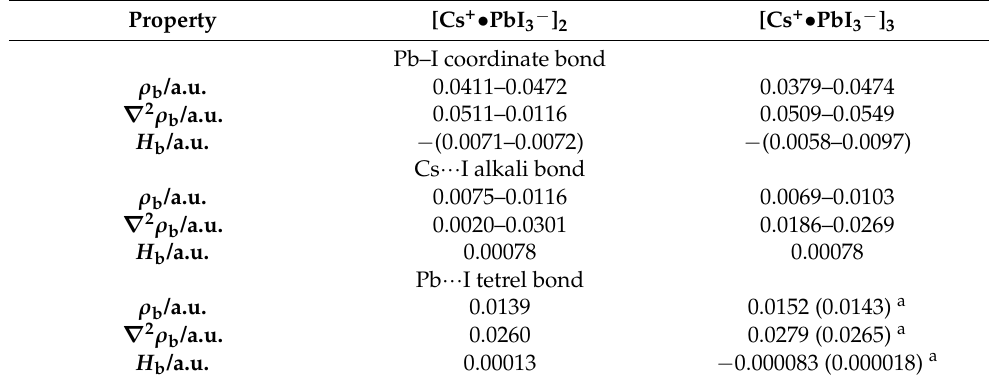
Table 5. Selected QTAIM-based charge density properties at Pb–I, Cs ··· I, and Pb ··· I bcps of